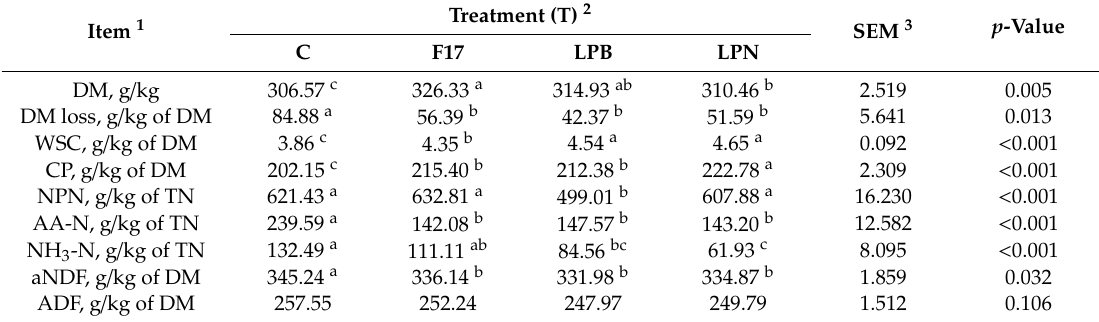
Table 3. Dry matter and chemical composition of alfalfa silages ensiled for 60